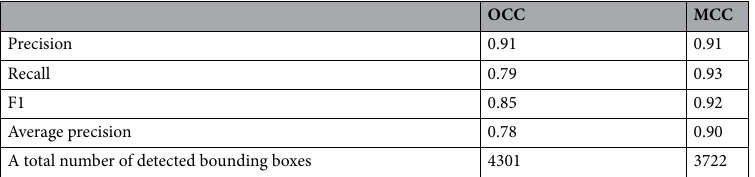
Table 1. Results of the detection rate metrics (precision, recall, average precision, and a total number of detected bounding boxes) with OCC and the MCC. Abbreviations: OCC = one-class classification, MCC = multi- class classification